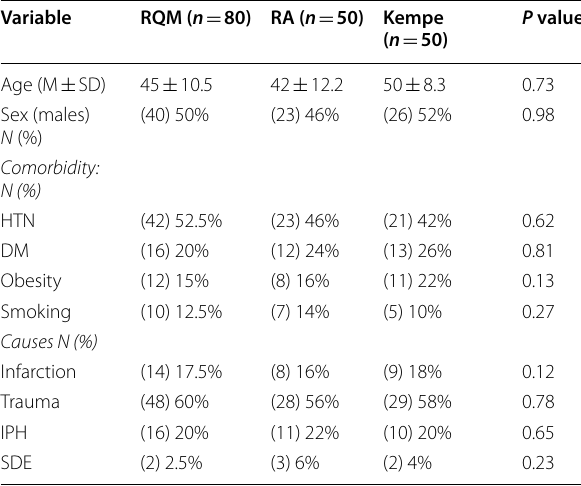
Table 1 Demographic and clinical characteristics of patient groupings